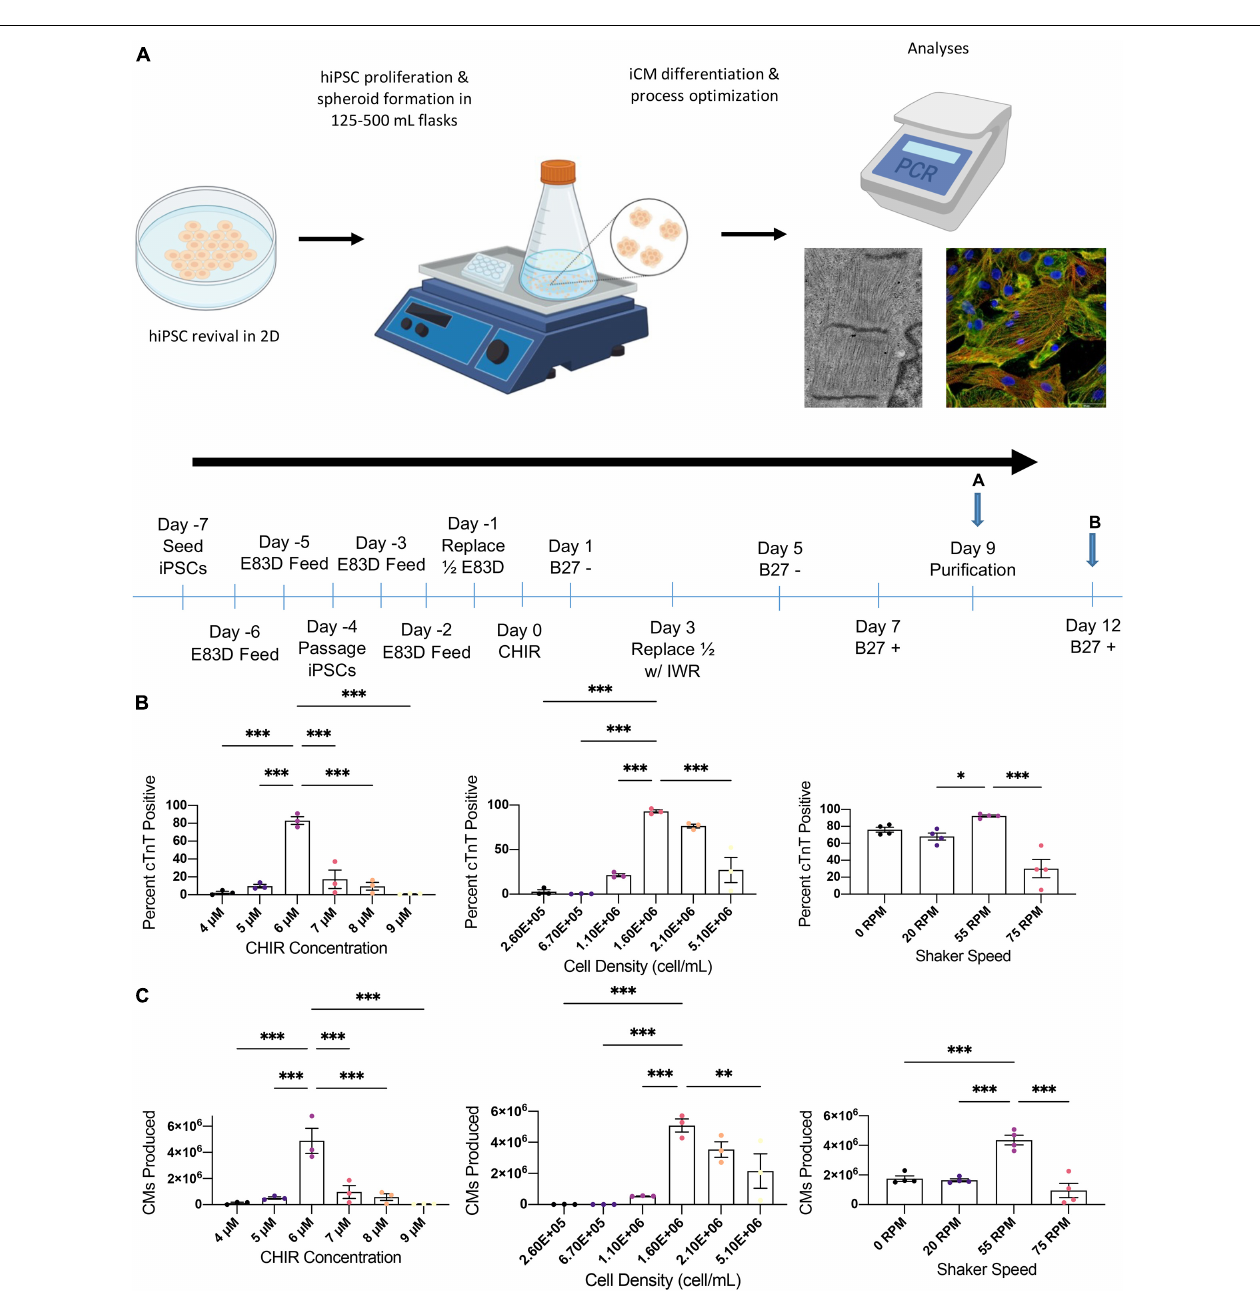
FIGURE 1 | Optimization of suspension differentiation protocol. (A) Schematic of the overall process and differentiation timeline for cardiac spheroid production pursued in this paper. Monolayer cultured iPSCs were seeded into 3D culture where they were differentiated followed by multimodal biomolecular and functional analysis. After seeding on day-7 cells are cultured in TeSR E8 3D for 7 days with a single passage on day-4. Cell density is calculated on day 0 and spheroids are then cultured in RPMI1640/B27- supplemented with CHIR on day 1 and IWR on day 3. Metabolic purification is initiated on day 9 using RPMI 1640 without glucose supplemented with B27 + and d-lactate. On day 12 and every 3 days thereafter, media is partially changed with fresh RPMI1640/B27 + . Optimization studies analyzed cells at point A and all characterization experiments used cells at point B. (B) Flow cytometric analysis of cTnT positive cells for optimization of differentiation conditions including CHIR concentration, cell density on day 0, and shaker speed. (C) Total cardiomyocytes produced in each differentiation condition during optimization. ∗ p < 0.05; ∗∗ p < 0.01; ∗∗∗ p < 0.001 ( n = 4).